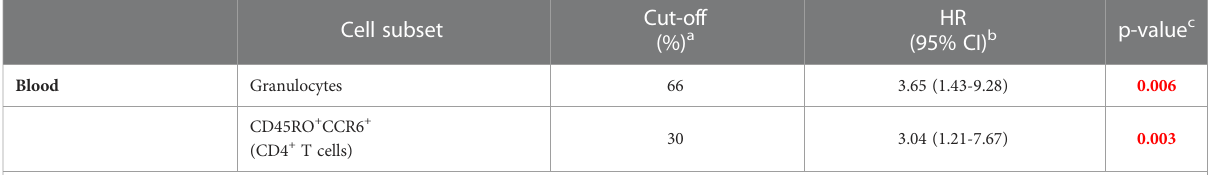
TABLE 3 Multivariate COX regression analysis of blood granulocytes and CD45RO + CCR6 + CD4 + T cell subset in SD OSCC patients. HR Cut-off Cell subset p-value c (95% CI) b (%) a Blood Granulocytes 66 3.65 (1.43-9.28) 0.006 CD45RO + CCR6 + 30 3.04 (1.21-7.67) (CD4 + T cells)